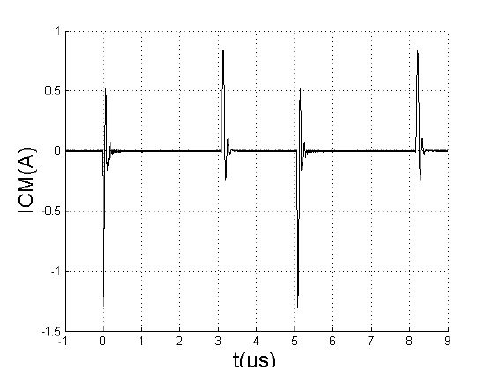
. CM Figure 21: Equivalent circuit of the common mode current